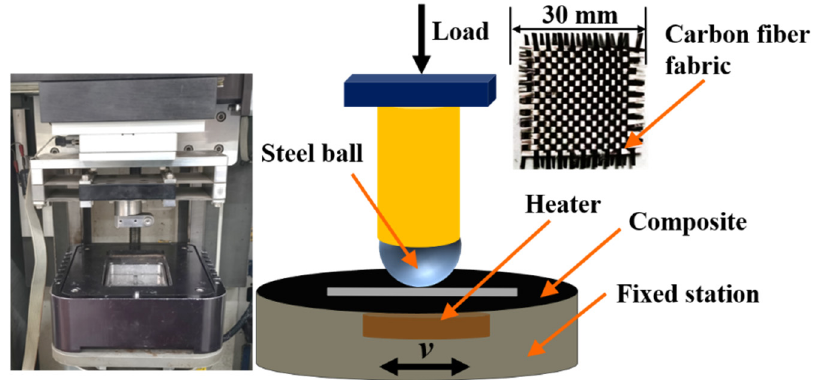
Figure 1. Test principle of dry sliding.